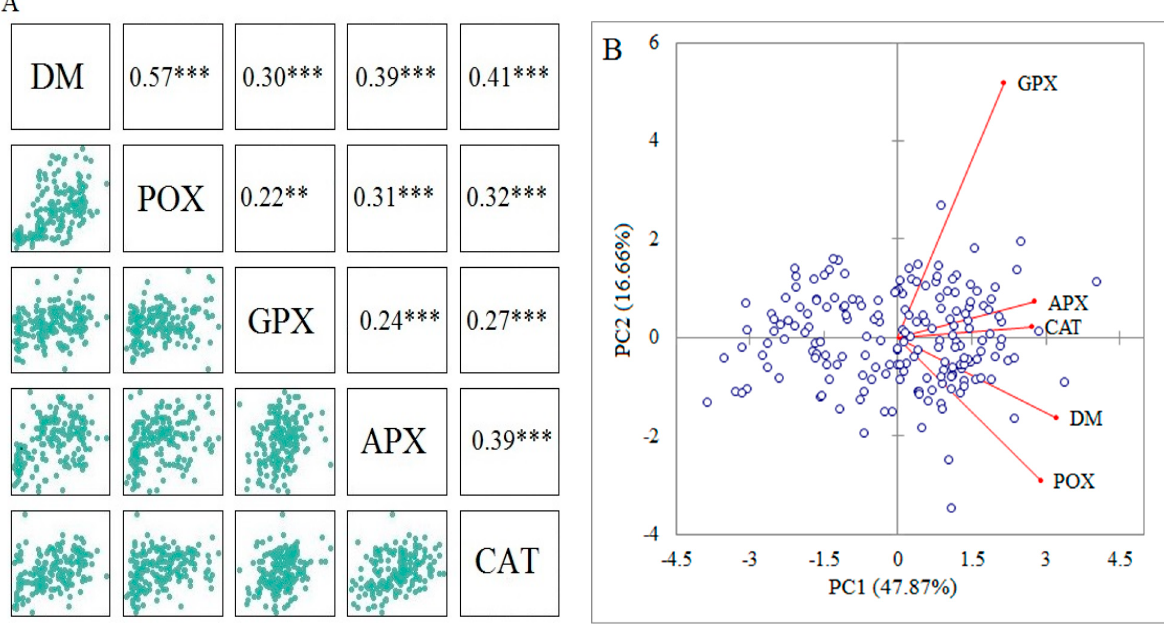
Figure 3. ( A ) The Pearson’s correlation coefficients between the measured biochemical traits and dry matter (DM). ( B ) The PCA-based biplot rendered by the first two components (PC1 and PC2) to show the distribution of investigated accessions based on the measured traits. ** and *** indicate significance at p < 0.01, and p < 0.001,